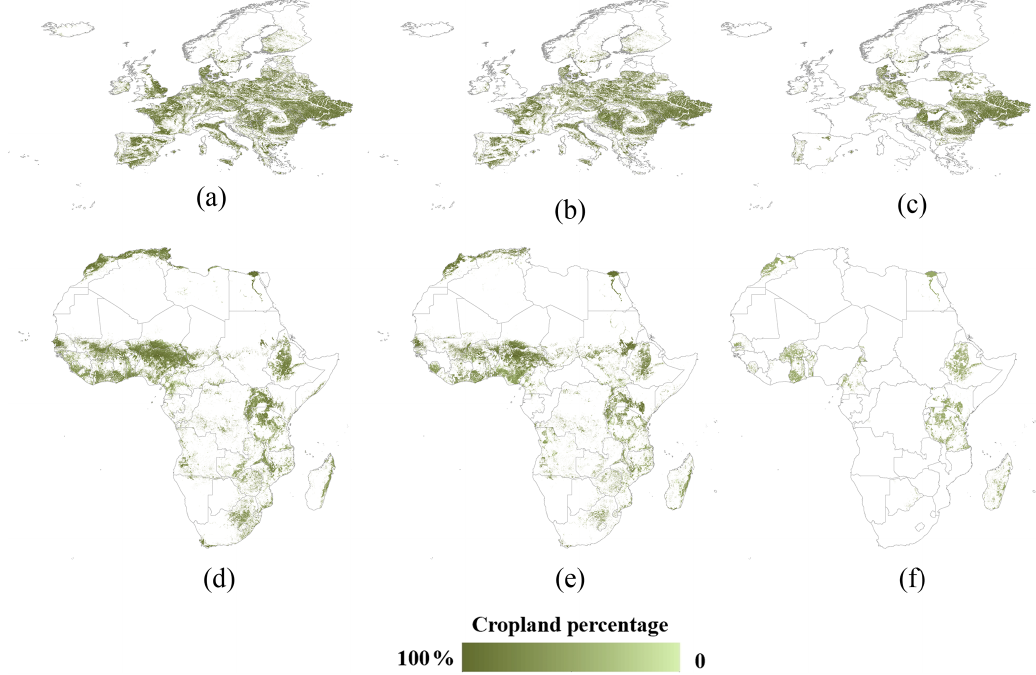
Figure 5. Statistics allocation results in Europe and Africa: (a) and (d) are the national allocation results; (b) and (e) are the first subnational allocation results; (c) and (f) are the second subnational allocation